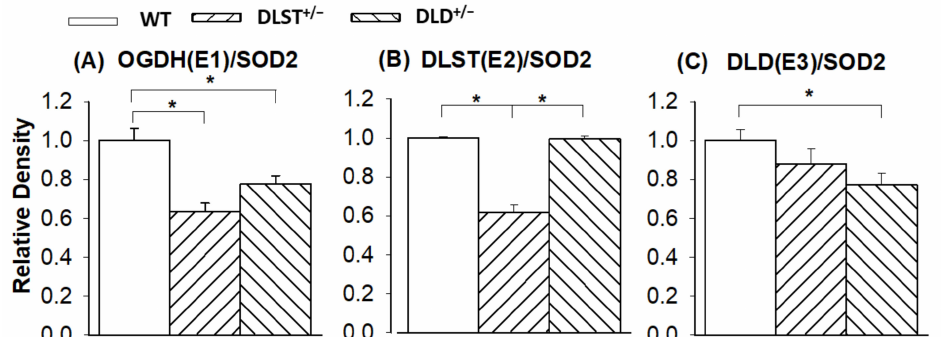
Figure 8. Western blot analysis and relative density changes for the KGDHc subunits, normalized for superoxide dismutase 2 (SOD2) protein expression, in brain mitochondria isolated from the wild-type and KGDHc-subunit-KO mice. ( A ) alpha-ketoglutarate/2-oxoglutarate (KGDH/OGDH) subunit; ( B ) dihydrolipoyl succinyltransferase (DLST) subunit; ( C ) dihydrolipoyl dehydrogenase (DLD) subunit. White bars: wild-type (WT); bars with left diagonal stripes: dihydrolipoyl succinyl- transferase mutation (DLST +/ − ); bars with right diagonal stripes: dihydrolipoyl dehydrogenase mutation (DLD +/ − ). Results are expressed as means of the relative densities ± S.E.M. ( N = 3–4). Statistically significant differences are indicated by asterisks; * p <